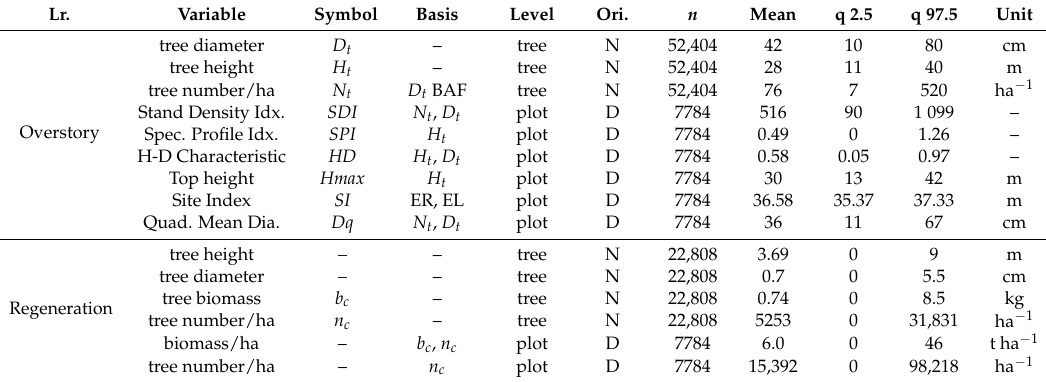
Table 1. Value characteristics of the base data set from the German national forest inventory NFI ( n = 7823) used to analyze the influence of the overstory on the biomass of the regeneration fraction. Columns q 2.5 and q 97.5 show the 2.5% and 97.5% quantile, respectively. Column n denotes